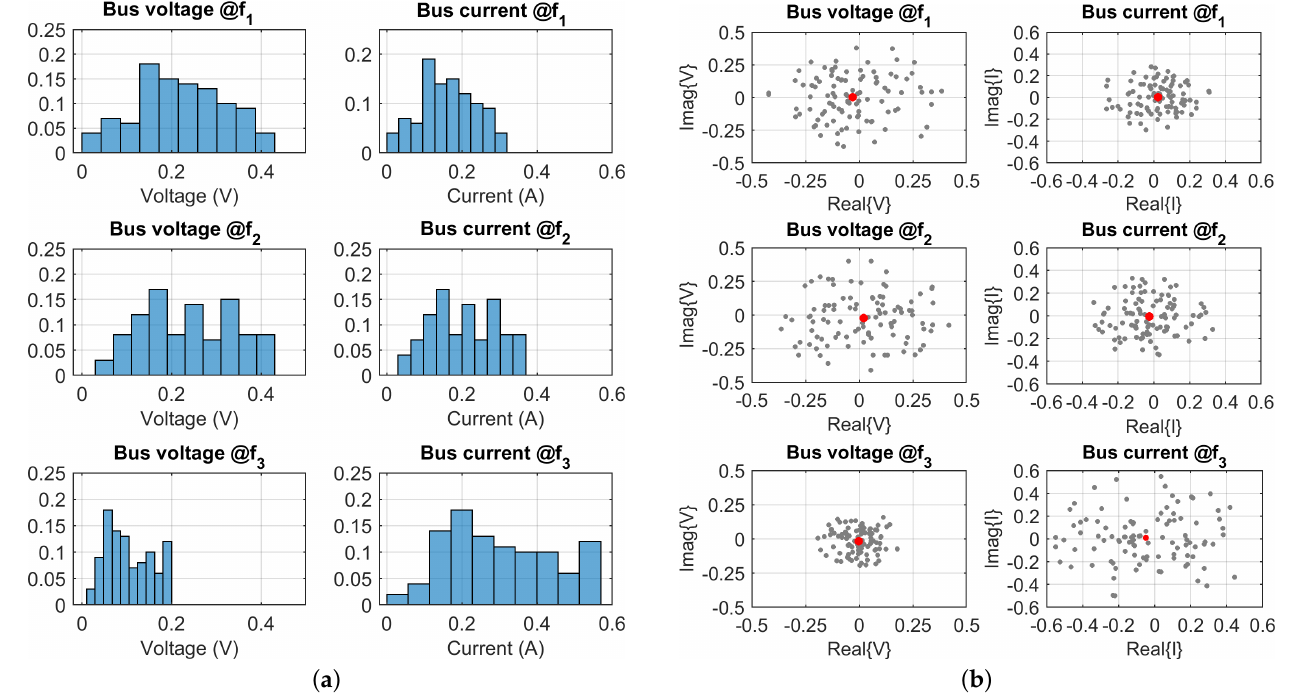
Figure 10. ( a , b ) Results of MCM simulations for the three-converter network with a reduced number of MCM trials (100); converters are separated by 100m of line cable segments.